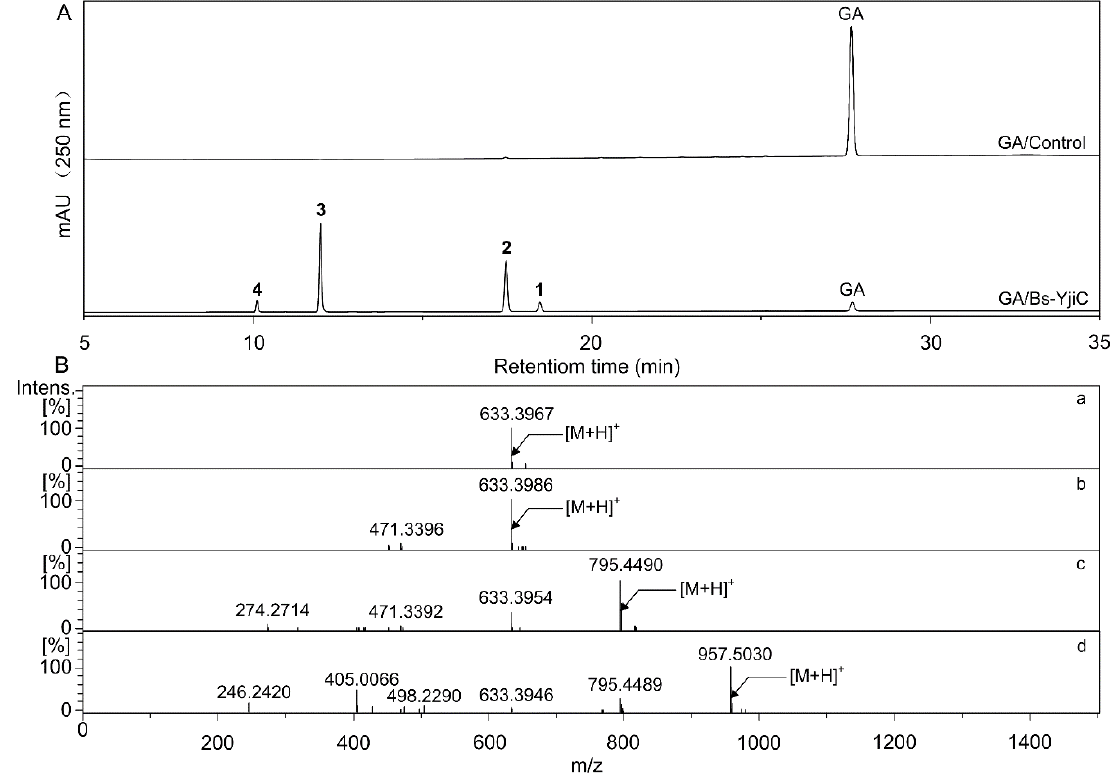
Figure 2. HPLC-ESI-MS analysis of the glycosylated products of GA. ( A ) HPLC chromatogram of Bs-YjiC-catalyzed reaction using GA as the aglycone. ( B ) MS spectra for products 1 (a), 2 (b), 3 (c), and 4 (d).